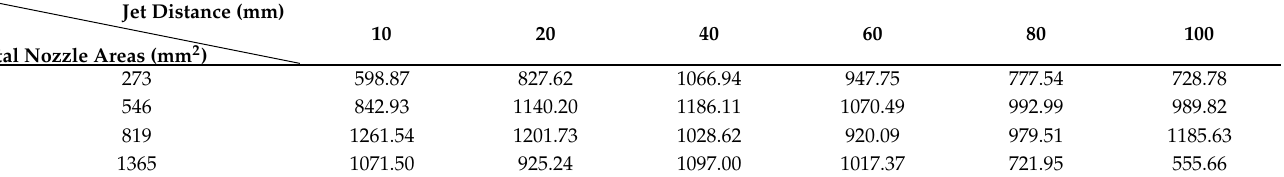
Table 3. Integrated